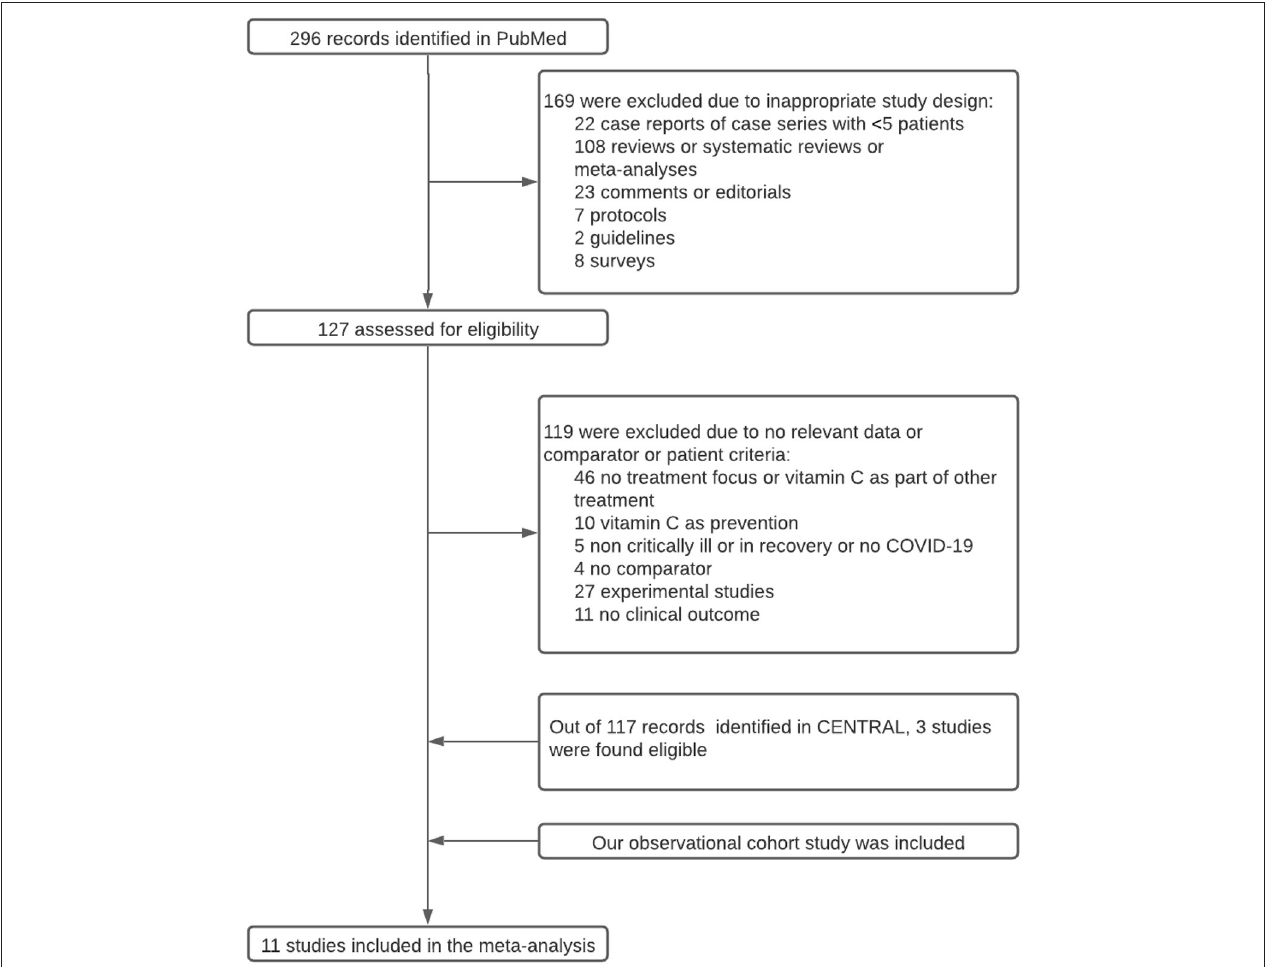
FIGURE 1 | Study flow